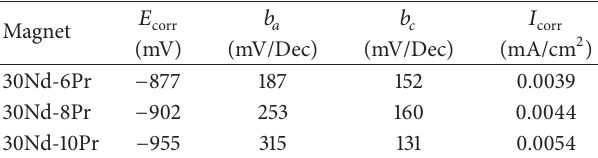
Table 3: Electrochemical parameters of the NdPr magnets tested in 3.5% NaCl solution at 25 ∘ C for 24